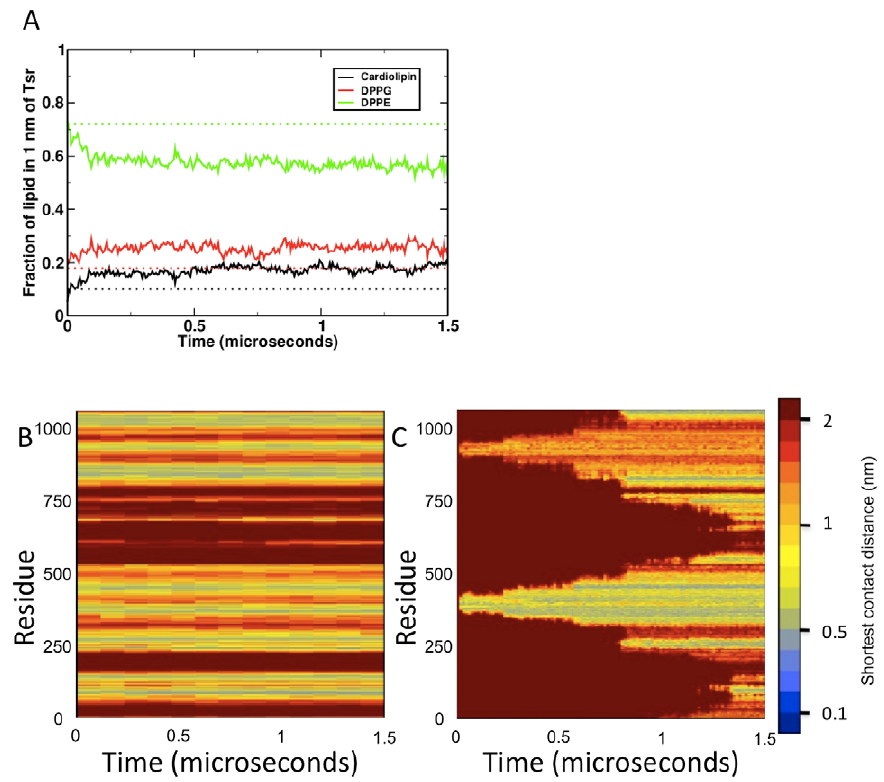
Figure 6. Interactions of proteins with their environment over time. (A) Specific enrichment of anionic lipids (cardiolipin and DPPG) within a 1 nm distance of the proteins over time, relative to DPPE. (B) and (C) Example interaction fingerprints from trimer-of-dimers and dimer vesicle simulations. These show the shortest distance between a given residue in one dimer and any residue in the binding partner over time (based on the approach in [19]). (B) shows dimer-dimer interactions within a trimer-of-dimers, and (C) shows dimer-dimer interactions which appear over the course of the simulation. Over time, the interaction surface in (C) changed to mimic the stable, unchanging binding surface of the trimer-of-dimers model (B), indicating that the structure naturally oligomerises along this